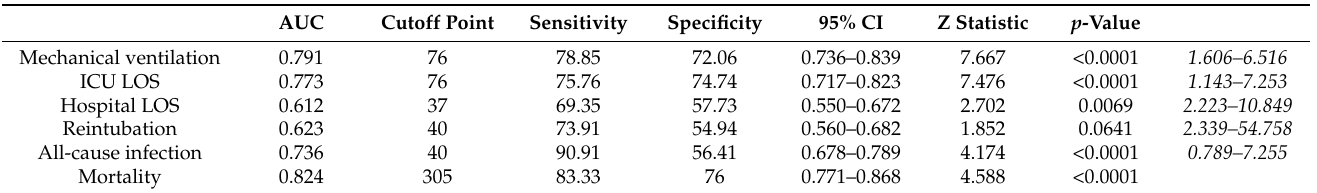
Figure 1. Receiver operating characteristic (ROC) analysis of postoperative ALT in predicting reintu- bation or all-cause infection for pediatric patients undergoing TCPC. ( a ) ROC curves of postoperative ALT in predicting reintubation; ( b ) ROC curves of postoperative ALT in predicting all-cause infection for pediatric patients post-TCPC operation. Table 3. Receiver operating characteristic (ROC) analysis of postoperative ALT in predicting different events for pediatric patients undergoing TCPC.